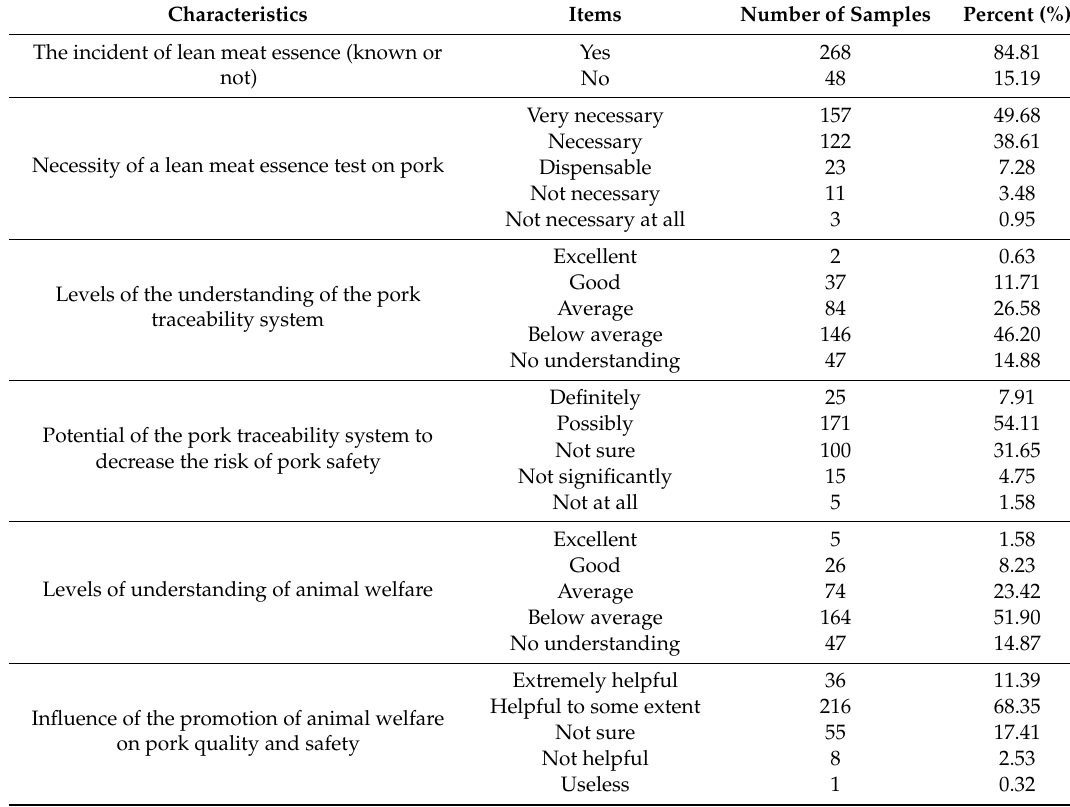
Table 3. The respondents’ cognition of lean meat essence, animal welfare, and